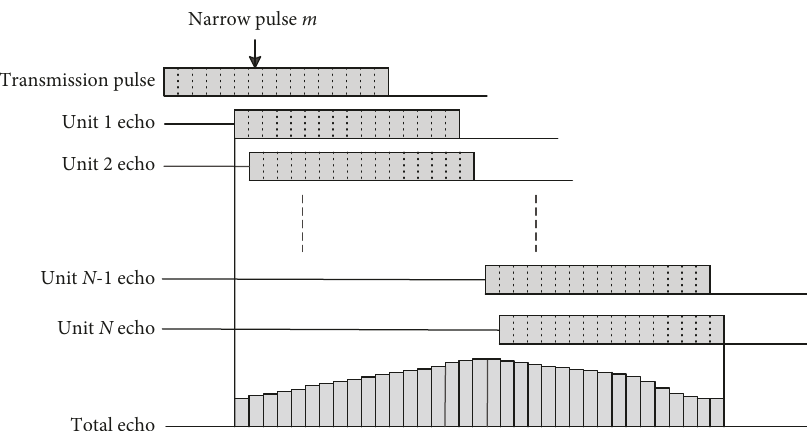
Figure 7: Diagram of the temporal decomposition